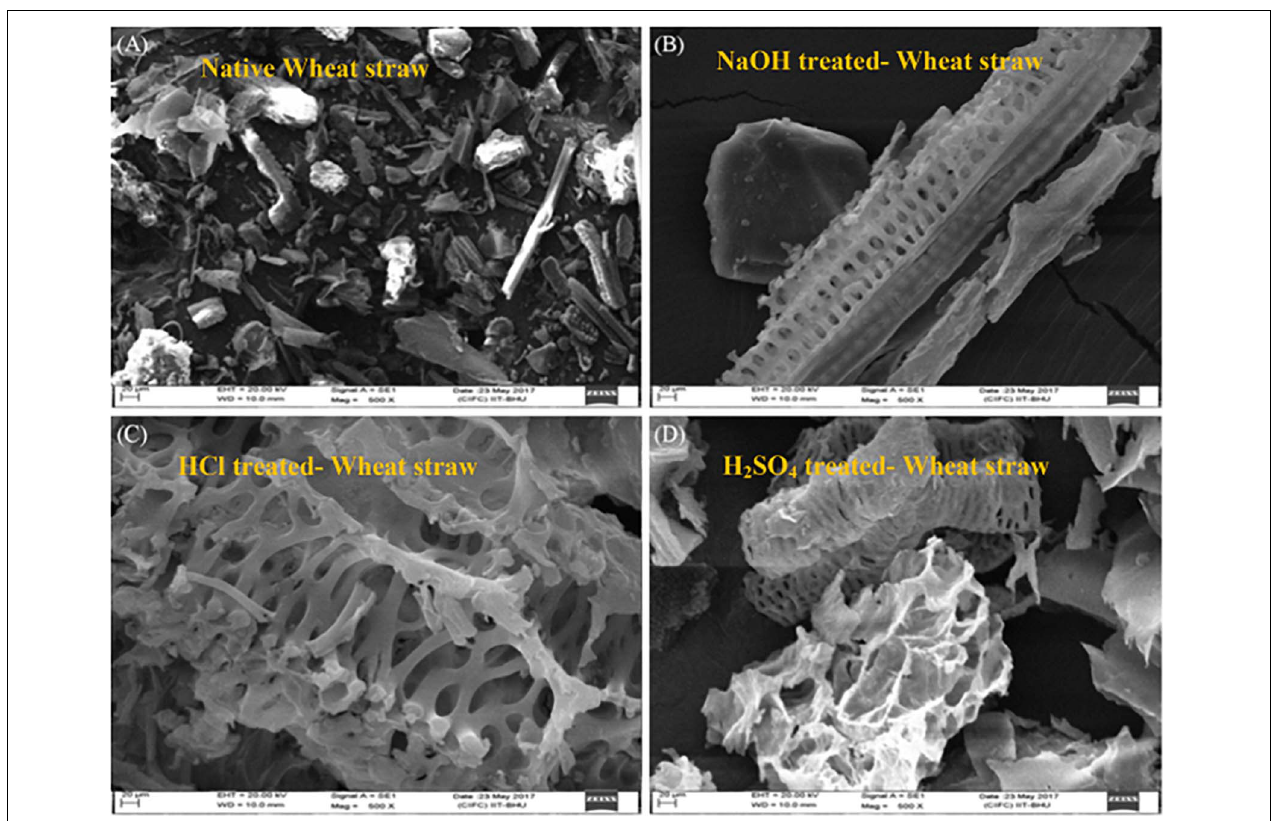
FIGURE 2 | Scanning electron microscopy micrographs of native wheat straw and all pre-treated wheat straw biomass: (A) native wheat straw, (B) NaOH-treated wheat straw, (C) HCl-treated wheat straw, (D) H 2 SO 4 -treated wheat straw (Dixit and Yadav,